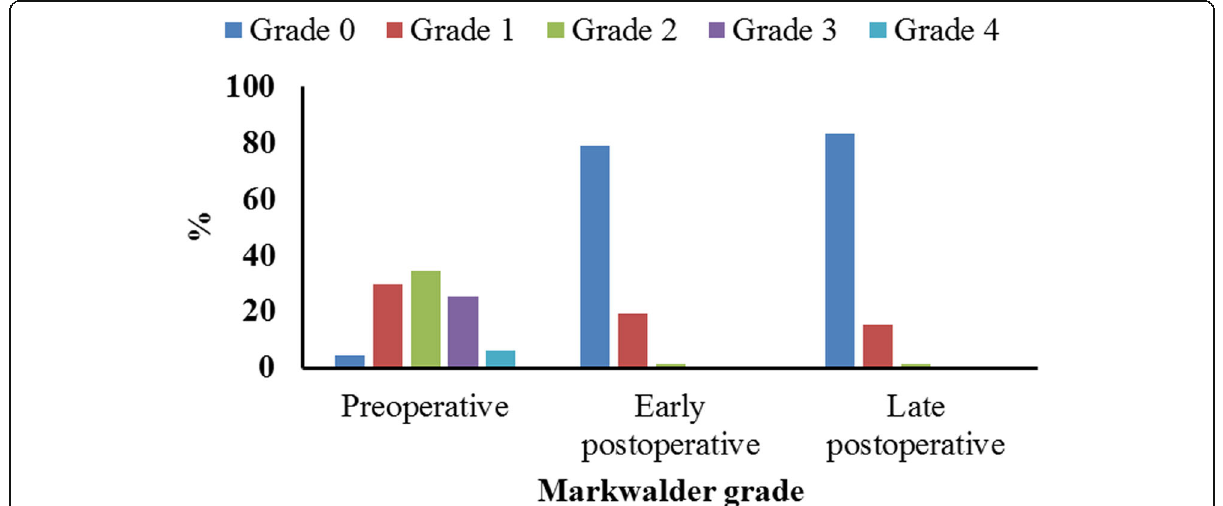
Fig. 1 Distribution of the patients according to Markwalder grade in preoperative, early, and late postoperative evaluations. The figure shows the relation between the Markwalder scale and the number of cases in each category. We can observe the marked improvement in Markwalder scale in both early and late postoperative follow-up